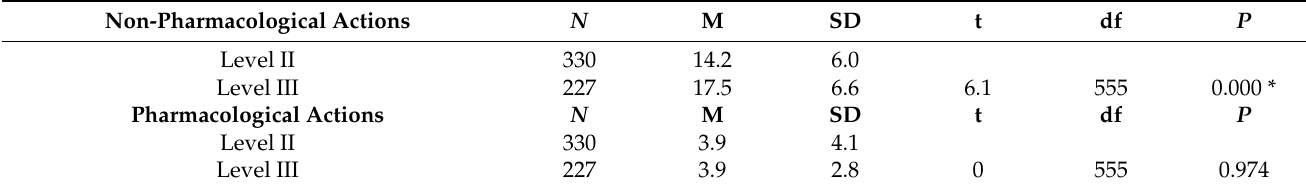
Table 7. Non-pharmacological and pharmacological actions vs. referral